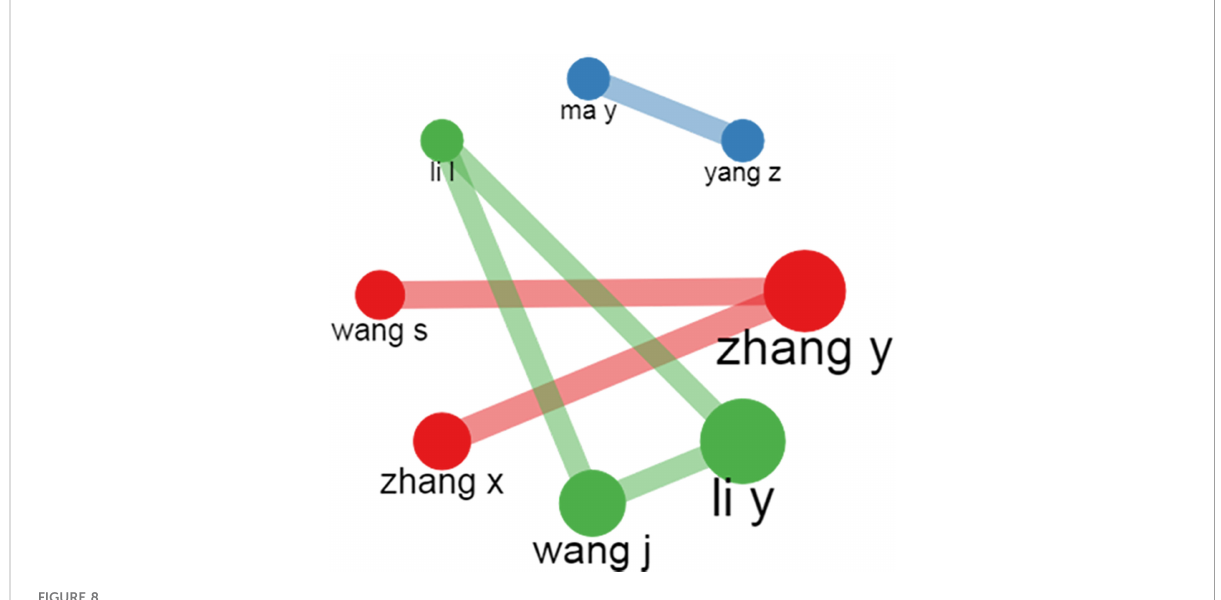
FIGURE 8 Pictorial representation of the author ’ s collaboration using author ’ s collaboration network